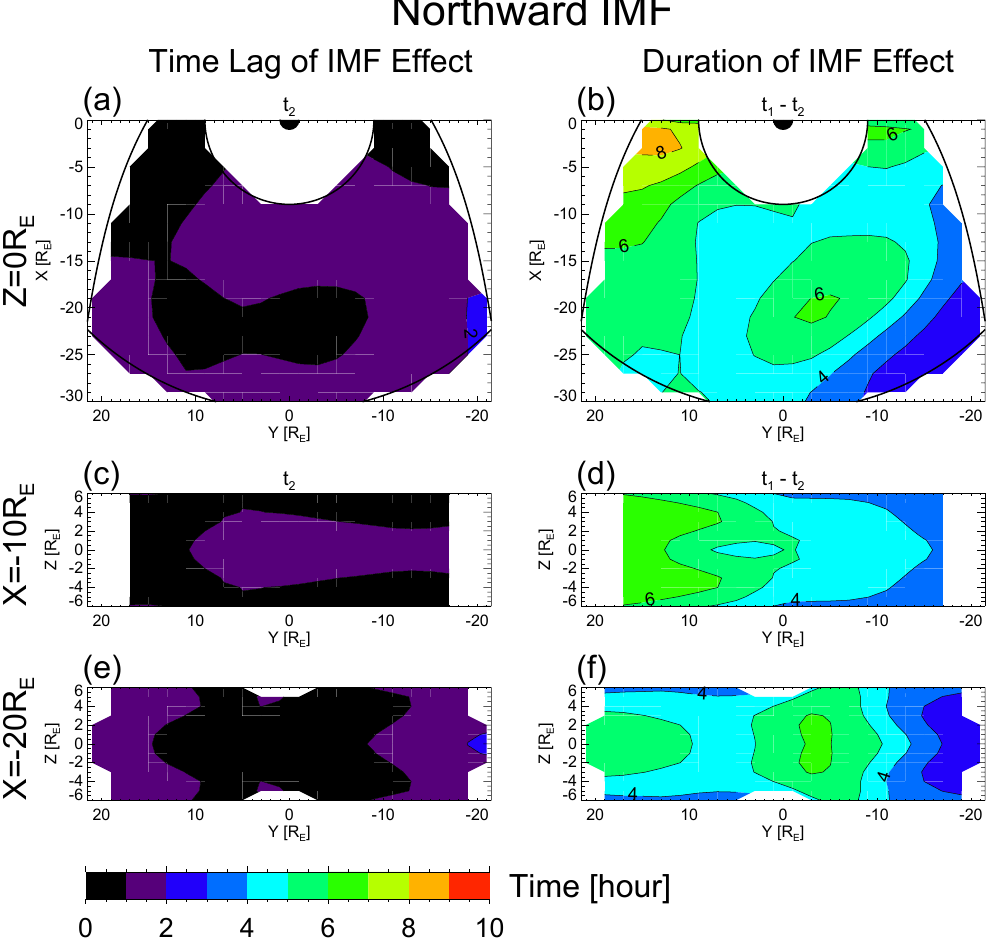
Fig. 8. Distributions of time lag and duration of IMF B z effect for northward IMF condition. Format is the same as Fig.